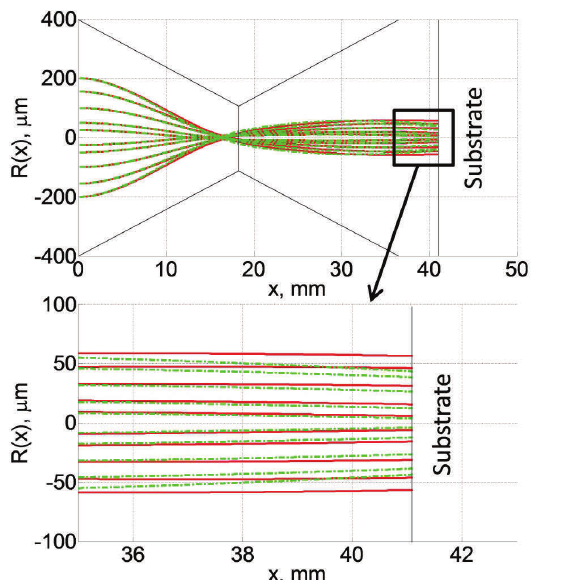
Figure 13. Trajectory of 6 µm diameter silver particles through a converging-diverging nozzle with Stokes and Saffman force applied (solid red), and Stokes, Saffman, and Magnus force applied (dashed green).